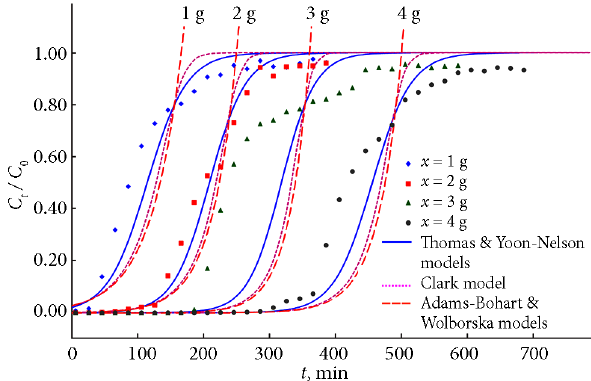
Figure 8. Effect of adsorbent grain size on breakthrough curve for As(V) adsorption removal by the PC-Fe/C adsorbent prepared with eucalyptus wood template (influent As(V) concentration: 20 mg/L; flow rate: 5.136 mL/min; pH: 3; adsorbent mass: 2 g; operating temperature: 35